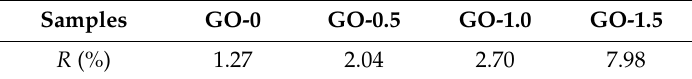
Table 5. The value of R of CSAs / GO aerogels with di ff erent GO contents.